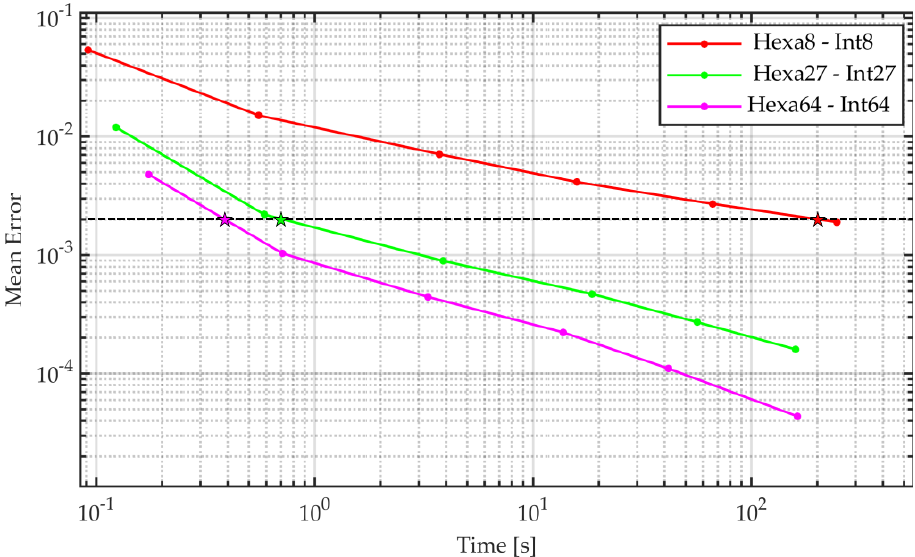
Figure 9. Convergence analysis of full − order linear, quadratic, and cubic FE formulations as a function of the time for eigenvalue computations.